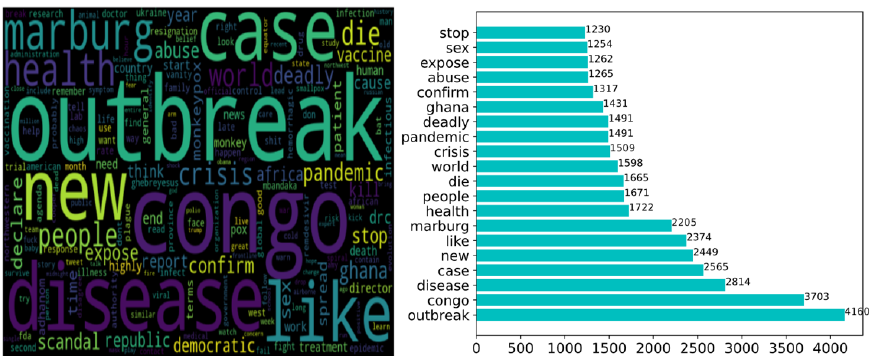
Figure 4. Word cloud and bar plot for